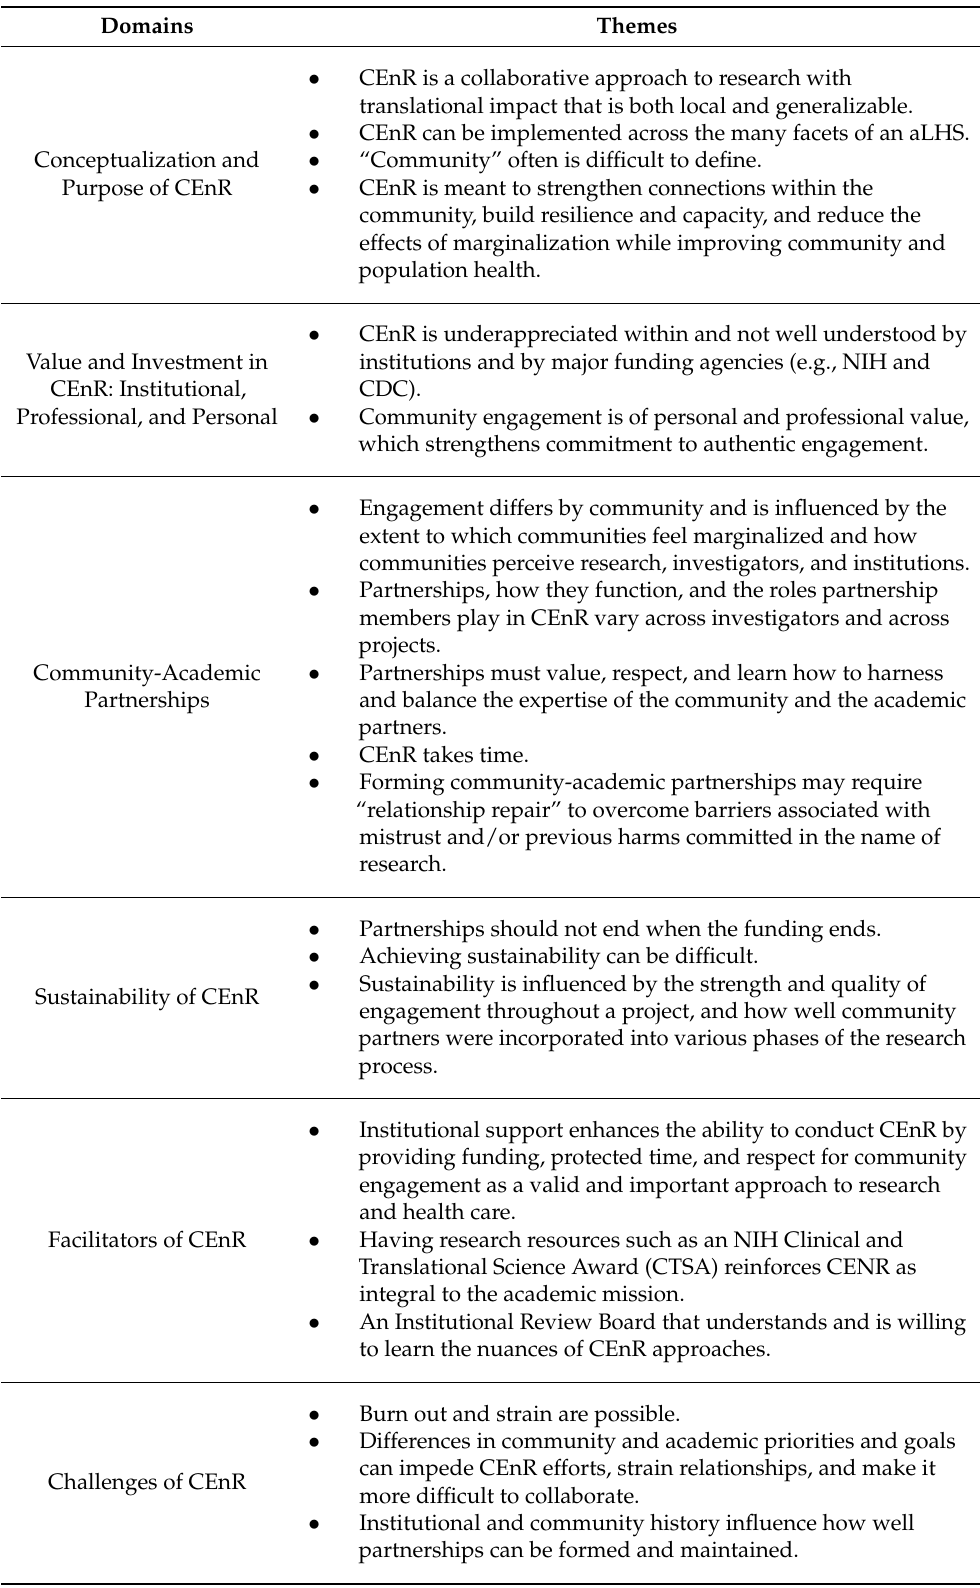
Table 3. Domains and themes related to conducting community-engaged research (CEnR) at an academic learning health system